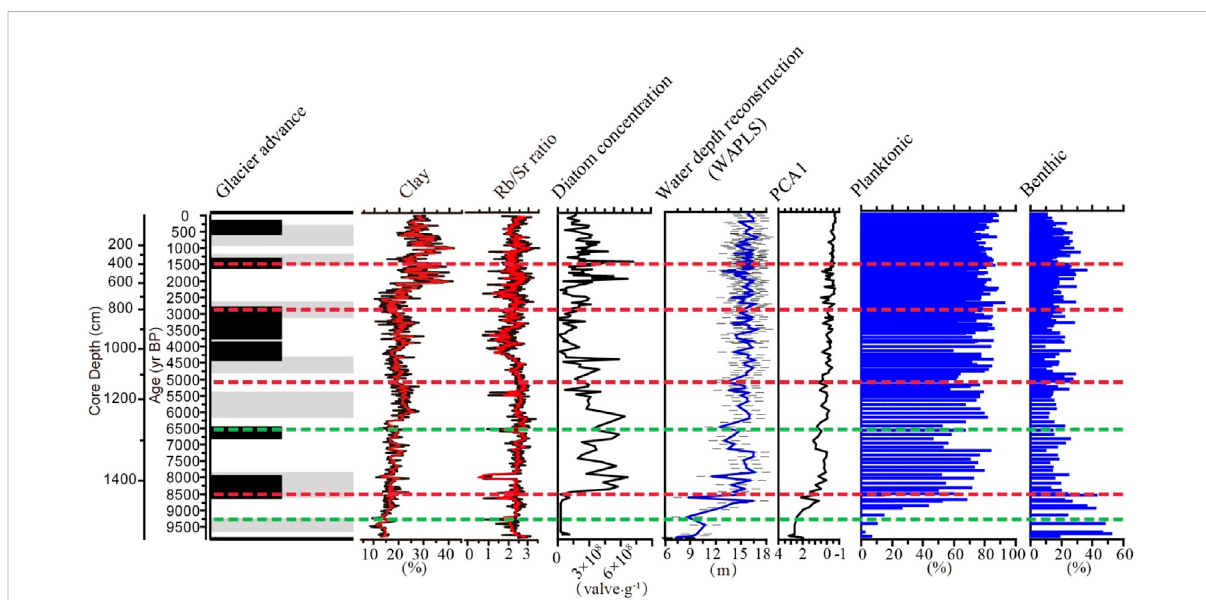
FIGURE 10 Record of glacier advance from Seong et al. (2009), on the left hand-side, compared with geochemical and diatom data derived from the Lake Kalakuli sequence. From left to right: percentage of clay, Rb/Sr ratio, diatom concentration, diatom sample scores on PCA axis-1 ( x -axis is reversed), diatom-based water depth reconstruction (with error bars corresponding to the RMSEP as dashed lines, in grey) and relative abundances of planktonic and benthic diatoms plotted against core depth and chronology. The red and green dashed lines indicate the diatom assemblage zones and subzones, respectively (see caption of Figure 8 for